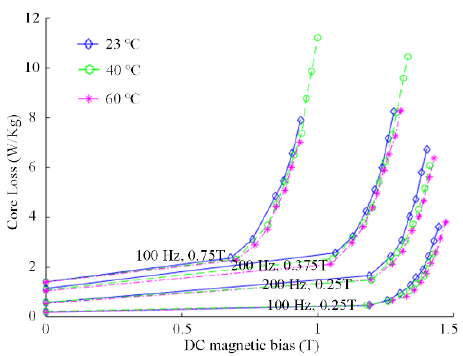
Figure 5. Core loss considering the dc magnetic bias.